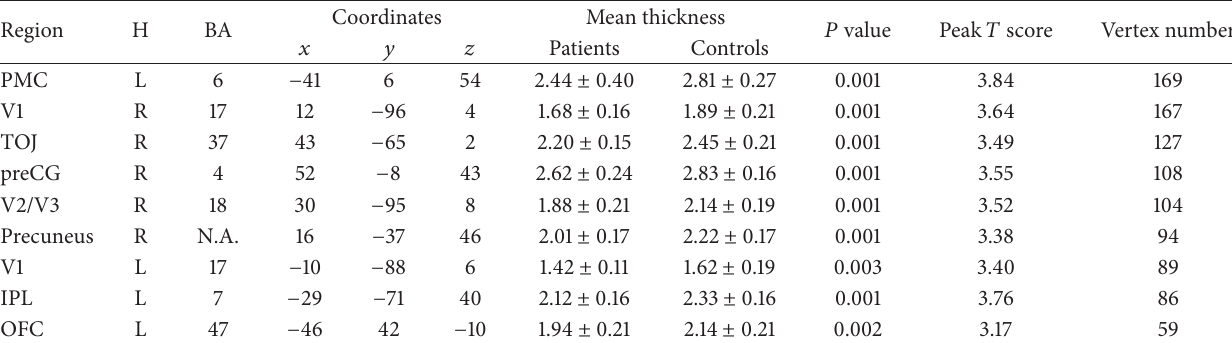
Table 4: Regions showing significant differences of cortical thickness across the whole